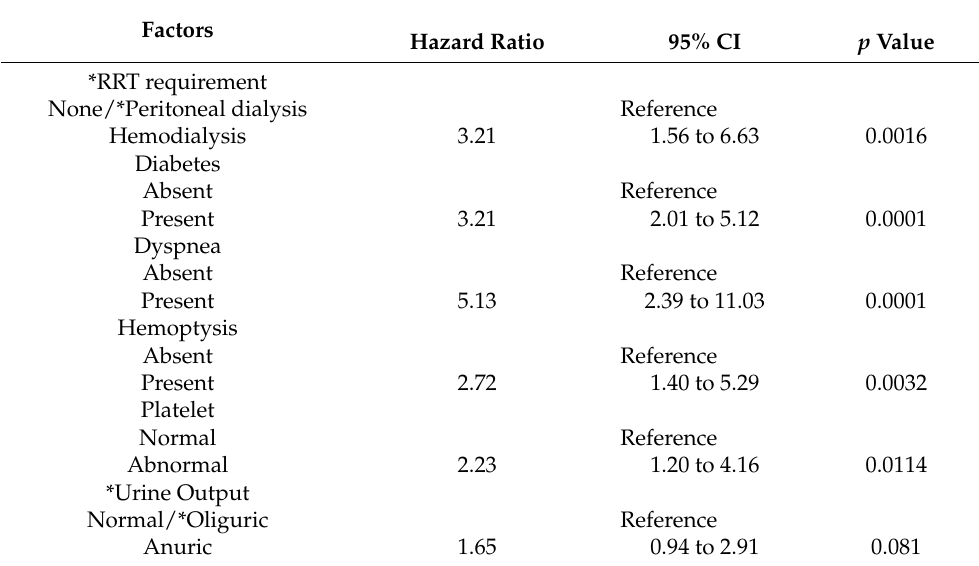
Table 8. Multivariate Cox regression on factors predicting complications